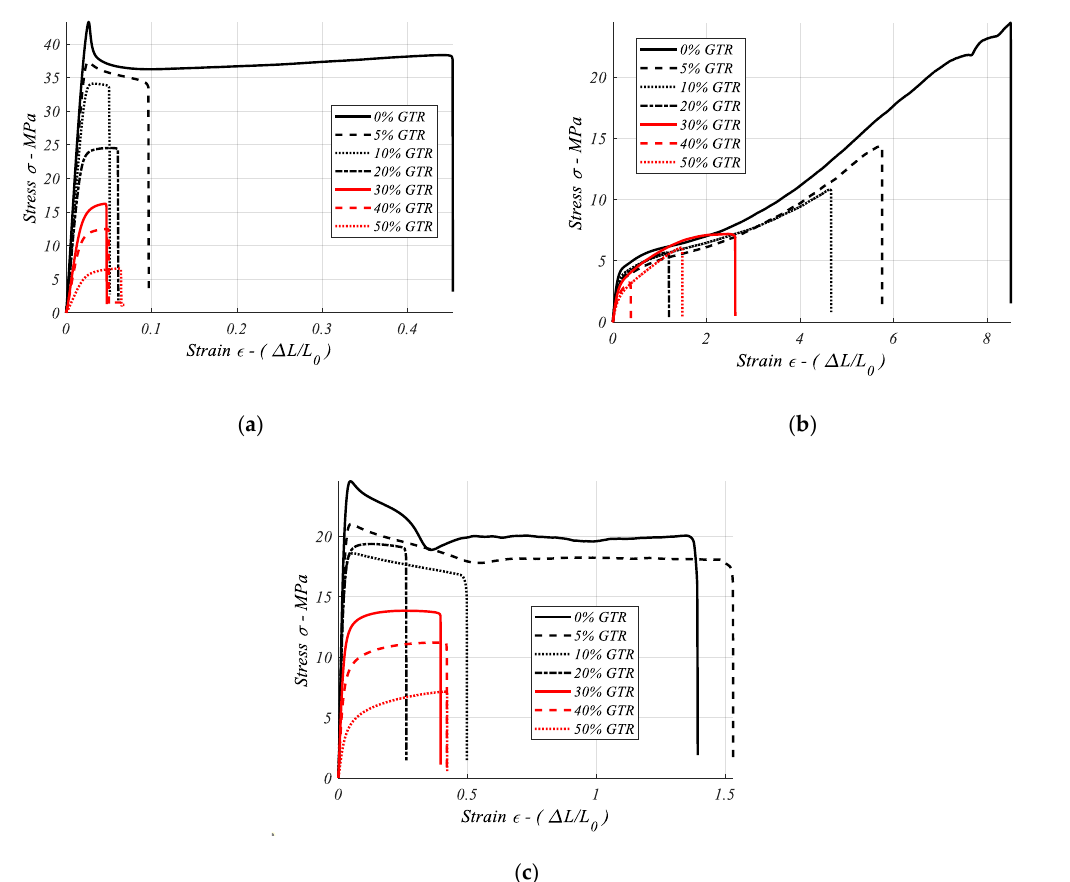
Figure 8. GTR composites curves of stress ( σ ) vs. strain ( ε ) tests, for several polymeric composites: ( a ) ABS / GTR; ( b ) EVA / GTR; ( c ) PP / GTR.